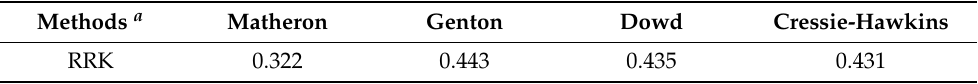
Table 2. The medians of θ ( u ) , calculated based on leave-one-out cross-validation for determination of the optimal auto-variograms.